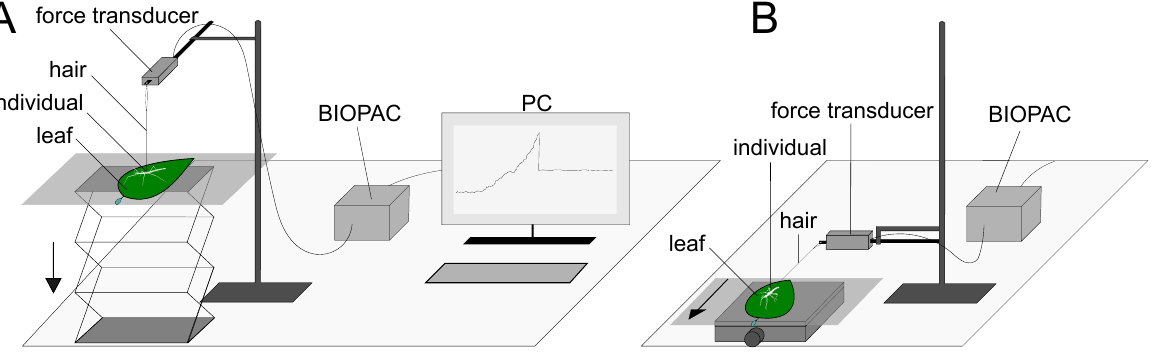
Figure 3. Experimental setup for the measurement of the pull-off force ( A ) and traction force ( B ). For simplification, the PC design is omitted in ( B ). The arrows indicate the direction in which the testing substrates were